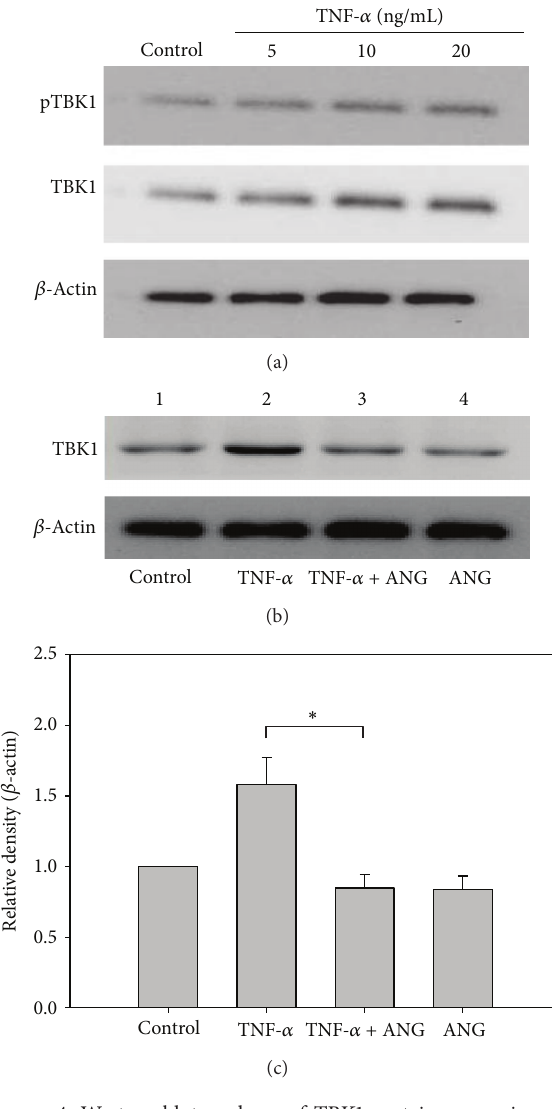
Figure 4: Western blot analyses of TBK1 protein expression and TBK1 phosphorylation (pTBK1). (a) TNF- 𝛼 treatment increased the expression of TBK1 and TBK1 phosphorylation in HCFs. (b) After ANG treatment, TBK1 protein expression was decreased in HCFs. ANG treatment did not affect TBK1 protein expression. (c) Densitometric analysis of the relative ratio of TBK1 in cells treated with TNF- 𝛼 only to those treated with TNF- 𝛼 +ANG. The experiments were performed in triplicate ( ∗ 𝑃 < 0.05